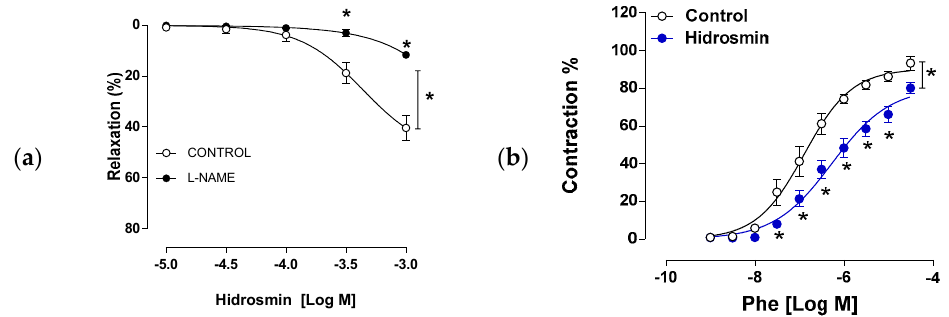
Figure 2. Effects of hidrosmin in vascular function of C57BL6 mouse aorta. ( a ) Concentration–response curves to hidrosmin in the absence (control) and presence of L-NAME. ( b ) Concentration–response curves to phenylephrine (Phe) in the absence (control) and presence of hidrosmin. Graphs represent the mean ± SEM of 4–5 independent experiments. * p < 0.05 vs. control by two-way ANOVA, followed by Bonferroni’s post-test.